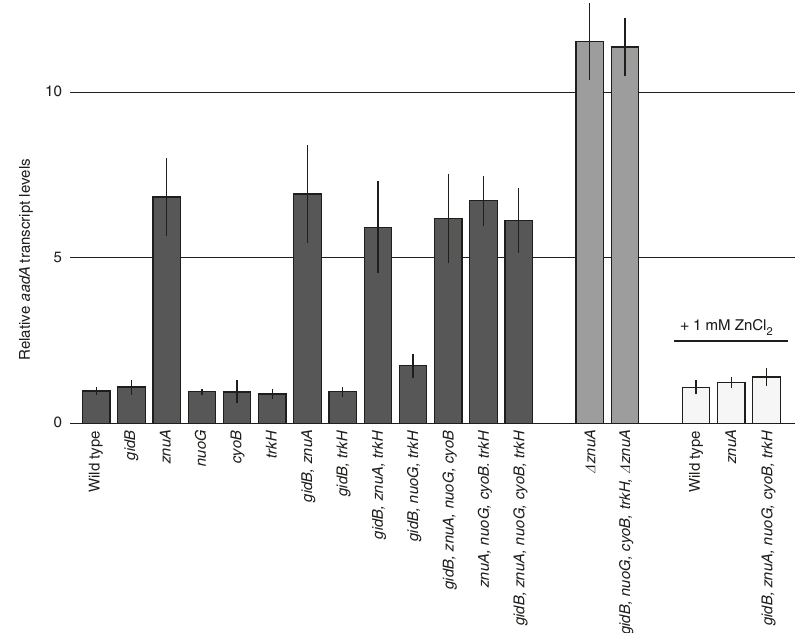
Fig. 3 Relative aadA transcript levels. Transcript levels of the aadA gene were determined in reconstructed mutants (dark gray), znuA deletion mutants (gray), and reconstructed mutants grown in the presence of 1 mM ZnCl 2 (white). Transcript levels were normalized to the housekeeping genes cysG and hcaT and all values are relative to transcript levels in the wild type. The error bars represent the standard deviation of two biological and three technical